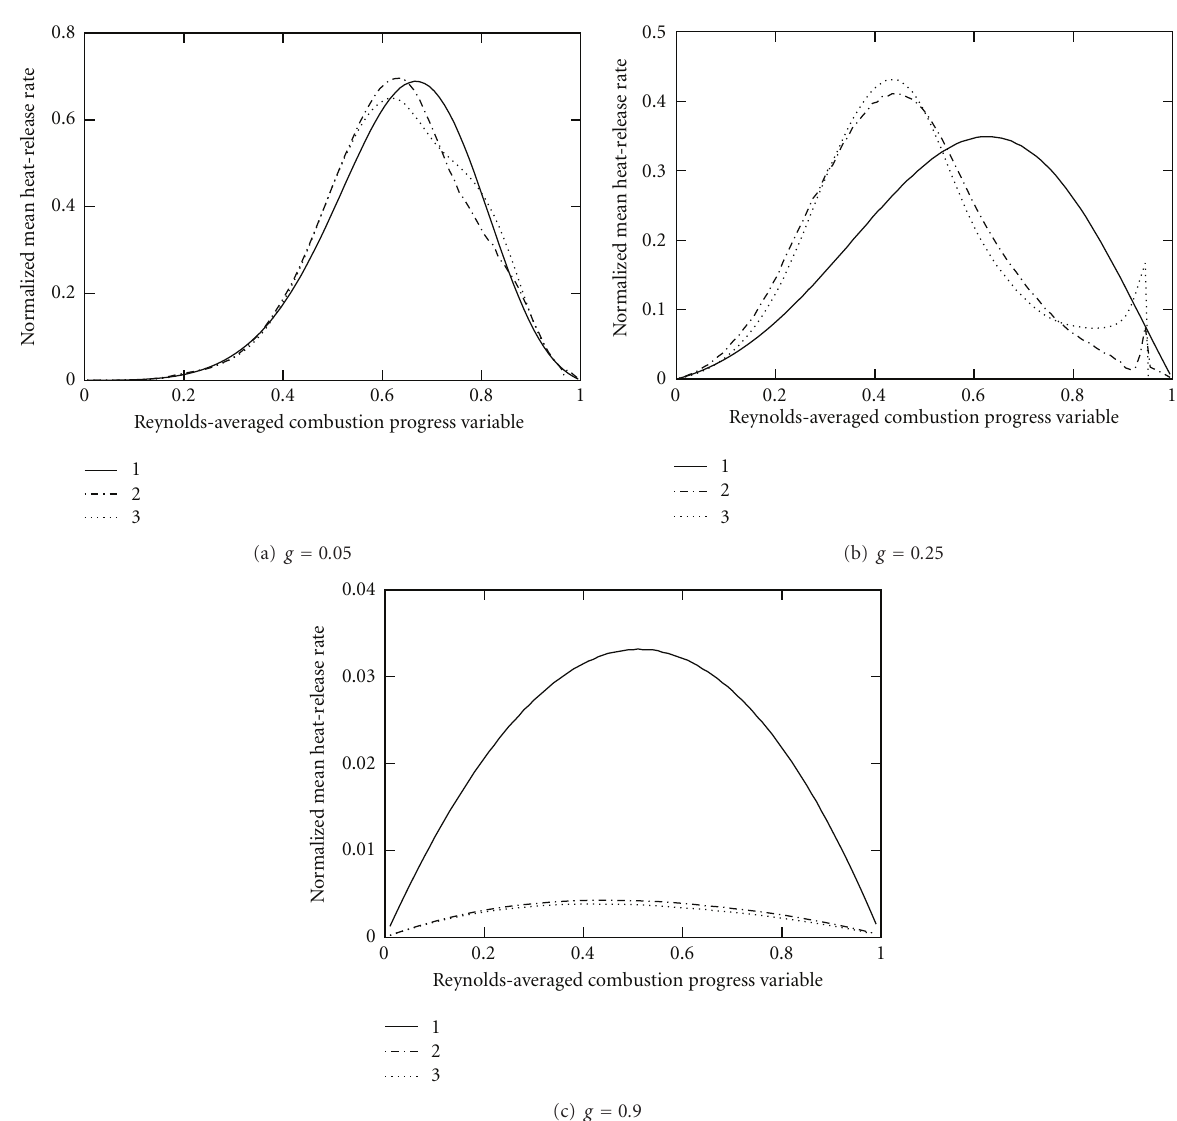
Figure 5: Dependencies of the normalized mean heat release rate on the Reynolds-averaged combustion progress variable, calculated for the beta-function PDF (curves 1), the R-2 δ -PDF (curves 2), and the 2 δ -PDF (curves 3). F = 1 . 0. (a) g = 0 . 05, (b) g = 0 . 25, (c) g = 0 .